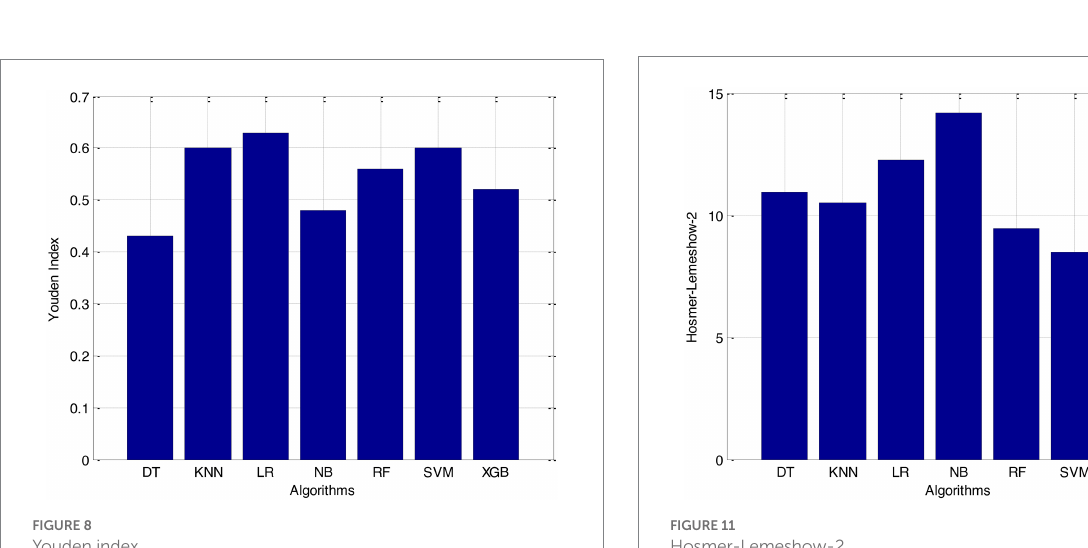
FIGURE 10 Brier score.